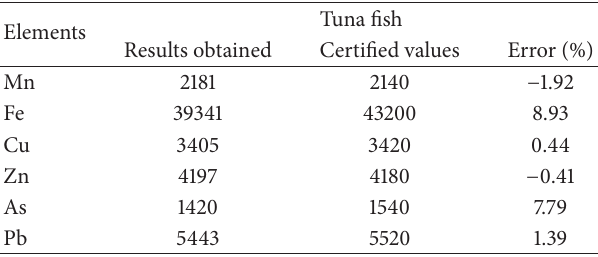
Table 1: Analysis of standard reference materials showing compar- ison between present results and the certified values (mgkg − 1